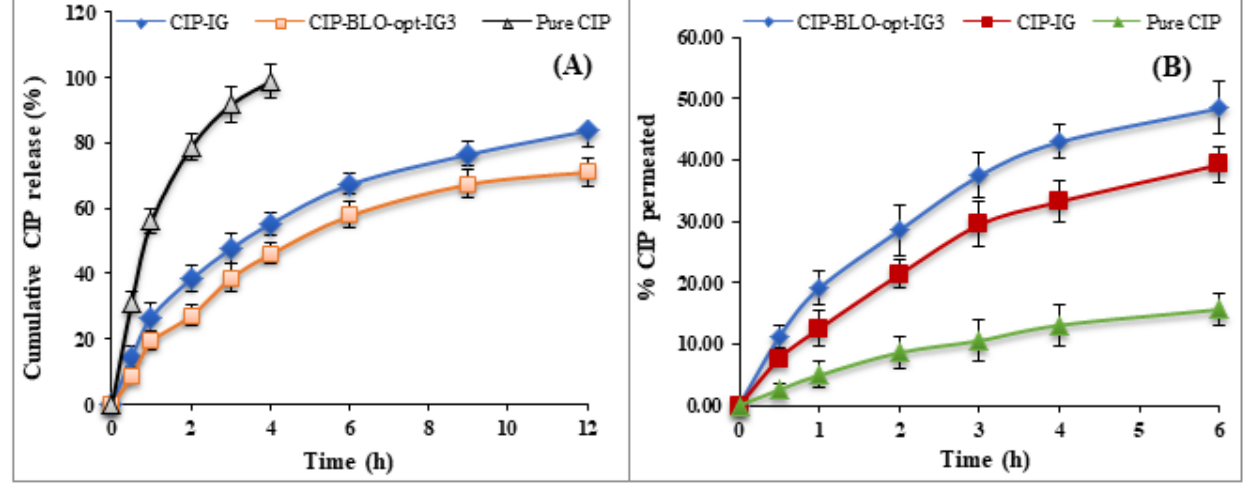
Figure 5. Showing ( A ) In-vitro release profile and, ( B ) ex-vivo permeation study of CIP-BLO-opt-IG3, CIP-IG, and pure CIP. mean ± SD, n =